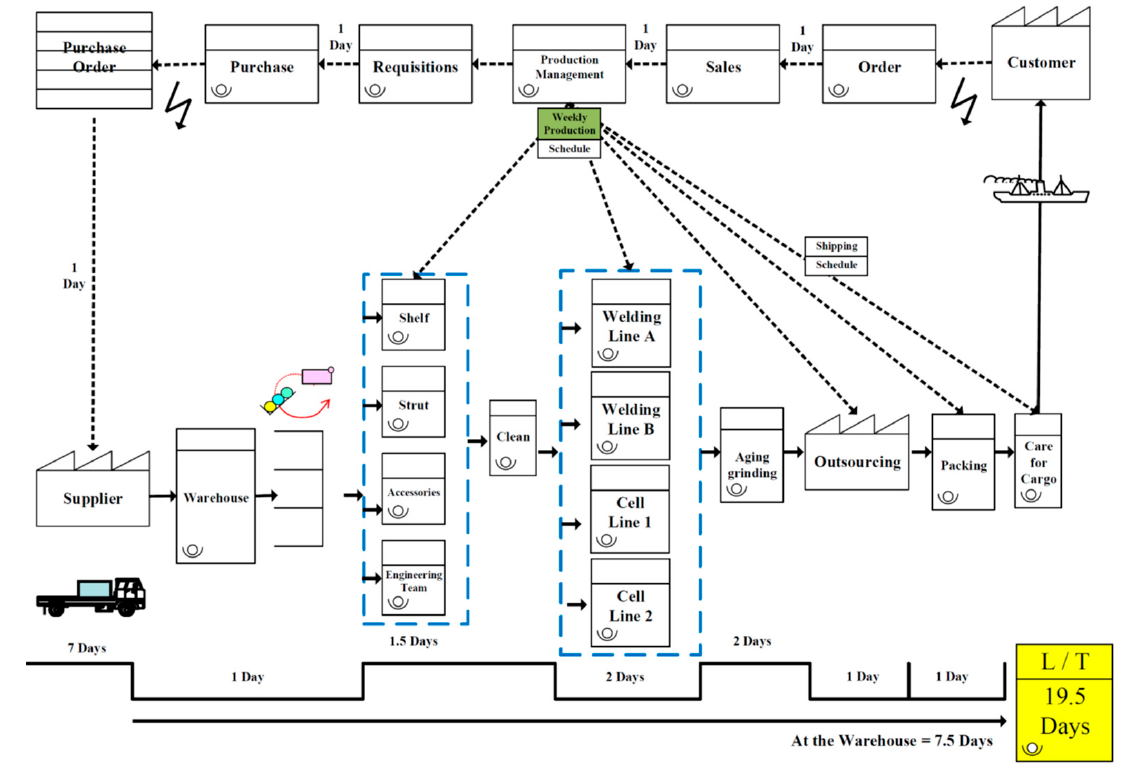
Figure 6. VSM after improvement.